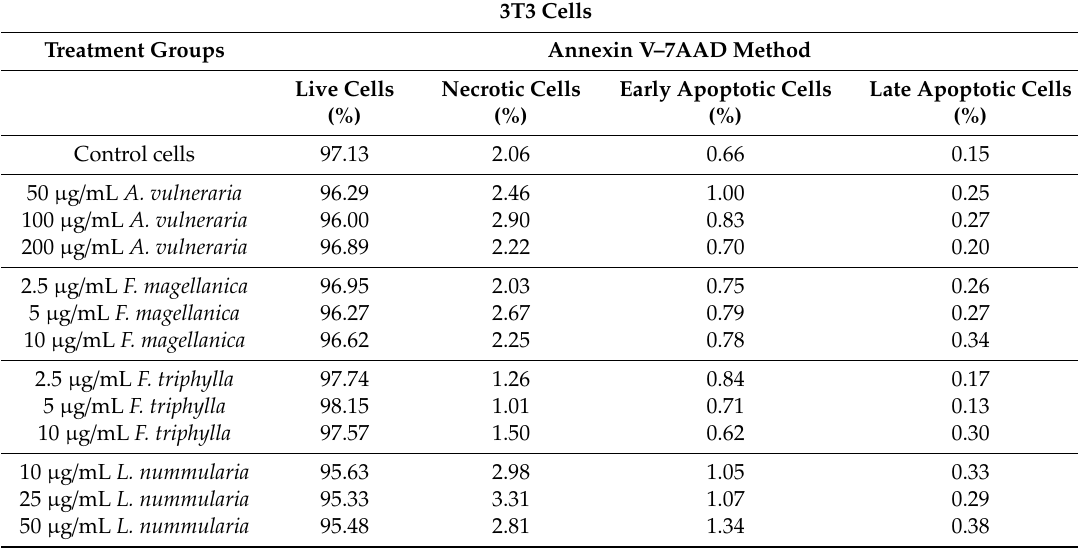
Table 4. Apoptosis-necrosis assay data of 3T3 cells treated with 50% ( v / v ) ethanolic extracts of